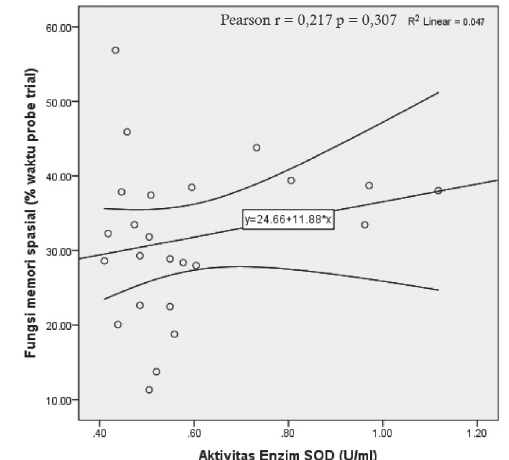
Figure 2. comparison mean of SOD enzyme activity (U/ ml) between groups. Data were presented in mean (SD). * P <0.05